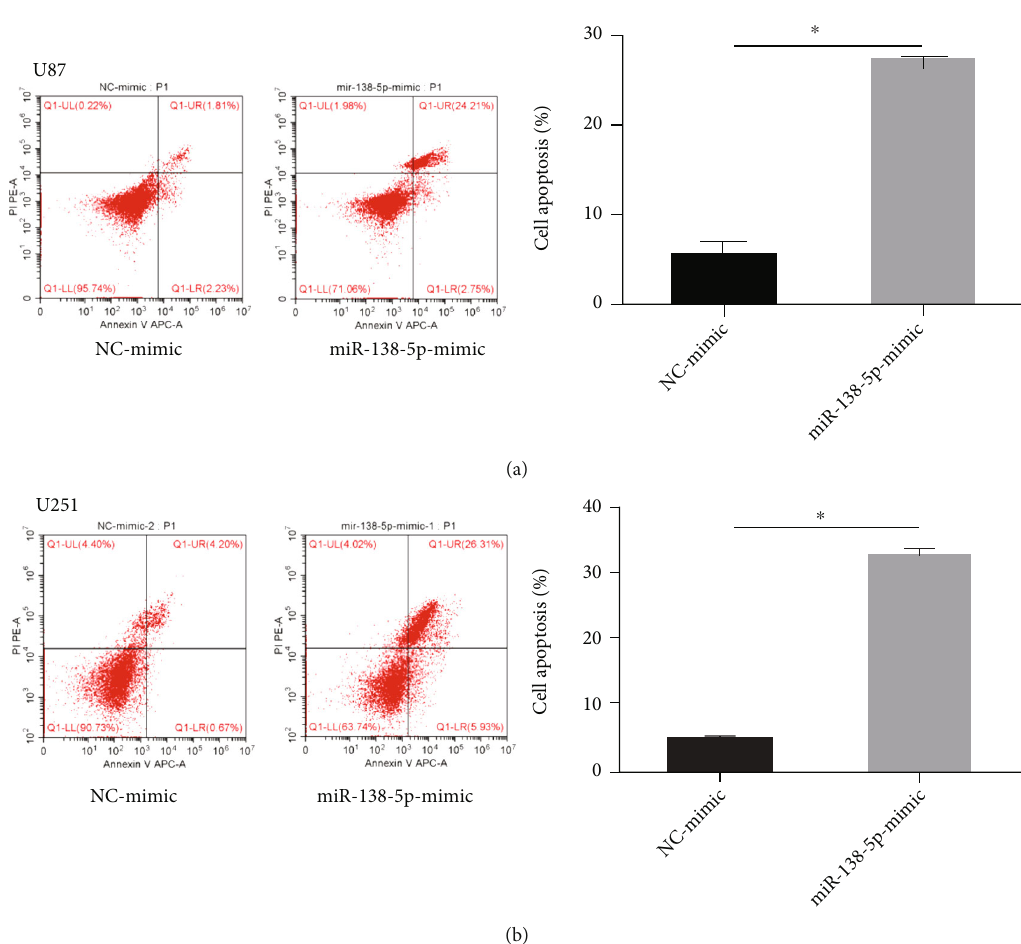
Figure 2: E ff ects of miR-138-5p on proliferation of U87 and U251 cells. (a) Flow cytometry was used to evaluate apoptosis rates in U87 cells transfected with NC or miR-138-5p mimics. (b) Flow cytometry was used to evaluate apoptosis rates in U251 cells transfected with NC or miR-138-5p mimics. Each experiment was repeated at least three times. ∗ P < 0 : 05